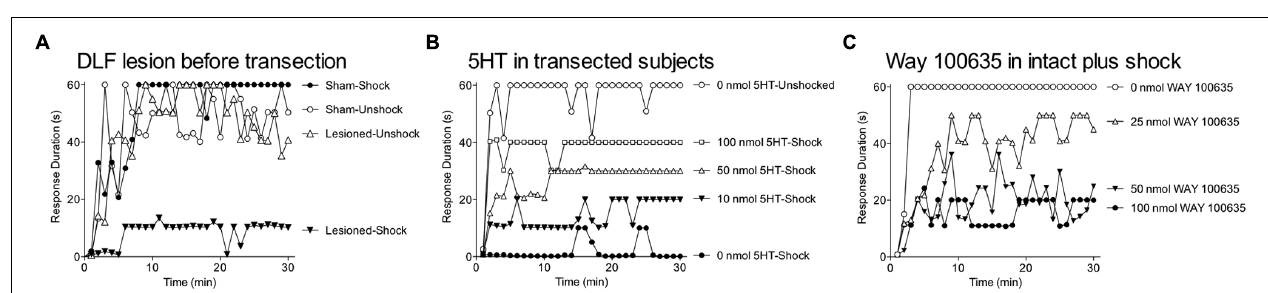
transection and instrumental testing. Shock induced a learning impairment in anesthetized (Pento-Shock) but not awake (Saline-Shock) rats. (C) Intact rats received saline or pentobarbital (50 mg/kg, i.p.) followed byVIS (Shock) or nothing (Unshock). Nociceptive reactivity was tested by applying a noxious thermal stimulus to the tail and measuring the latency to exhibit a tail-withdrawal (tail-flick). In awake rats (Saline), shock treatment induced antinociception. Shock had no effect on tail-flick latencies in anesthetized (Pento) rats. Adapted from Crown and Grau (2005) andWashburn etal. (2007).